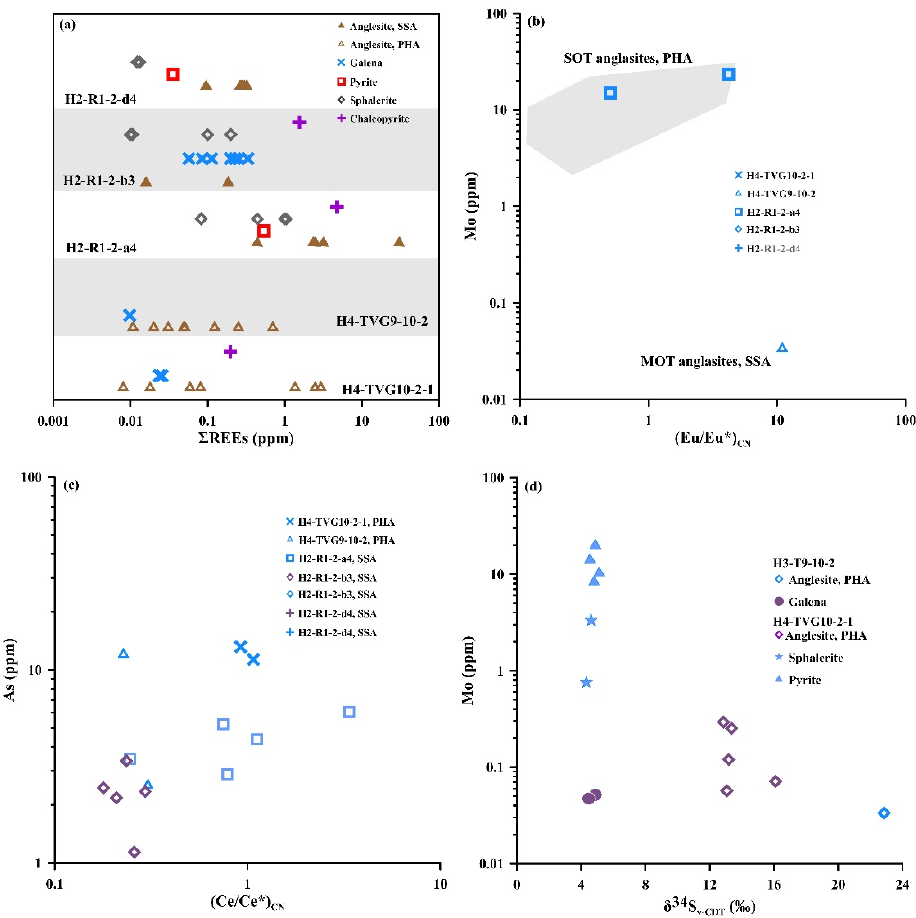
Figure 8. Plots of anglesite and sulfide minerals in OT hydrothermal sulfide deposits: ( a ) Σ REE dis- tribution range; ( b ) Mo vs. (Eu/Eu*) CN ; ( c ) As vs. (Ce/Ce*) CN ; ( d ) Mo vs. δ 34 S v-CDT . PHA—primary hydrothermal anglesite; SSA—secondary supergene anglesite.